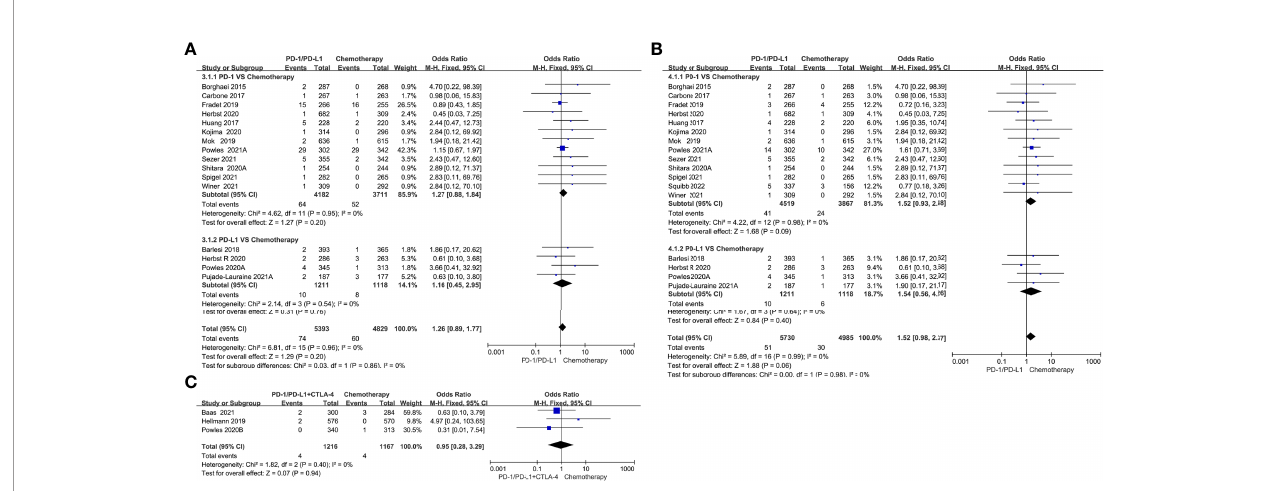
FIGURE 4 | Forest plots of the risk of all-grade and grade 3-5 cardiotoxicity calculated by the fi xed effect model. (A) The risk of all-grade cardiotoxicity in PD-1/PD- L1 inhibitors VS Chemotherapy group. (B) The risk of grade 3-5 cardiotoxicity in PD-1/PD-L1 inhibitors VS Chemotherapy group. (C) The risk of